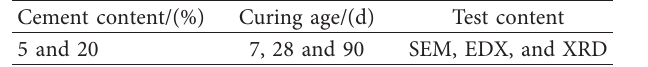
Table 4: The CMS microtest scheme. Cement